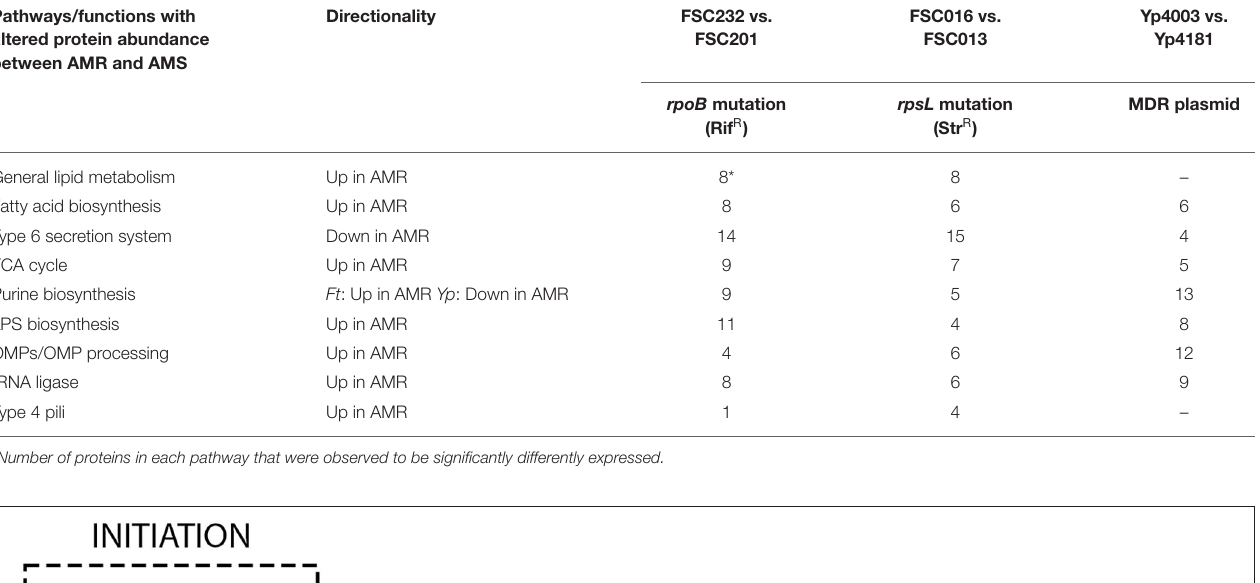
TABLE 6 | Major Y. pestis cellular functions and pathways influenced by AMR status (and compared to those observed for F. tularensis ). Pathways/functions with altered protein abundance between AMR and AMS